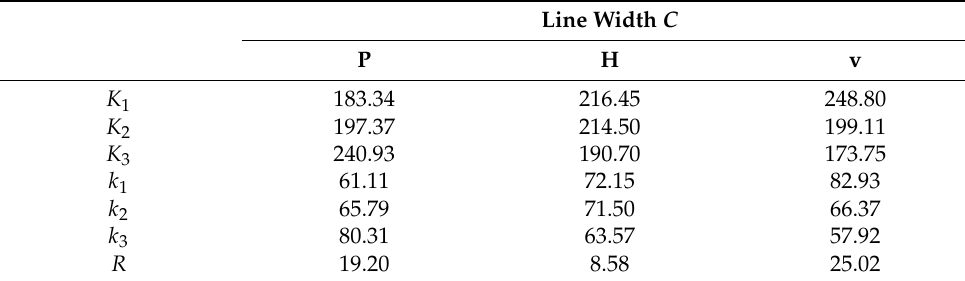
Table 5. Range analysis